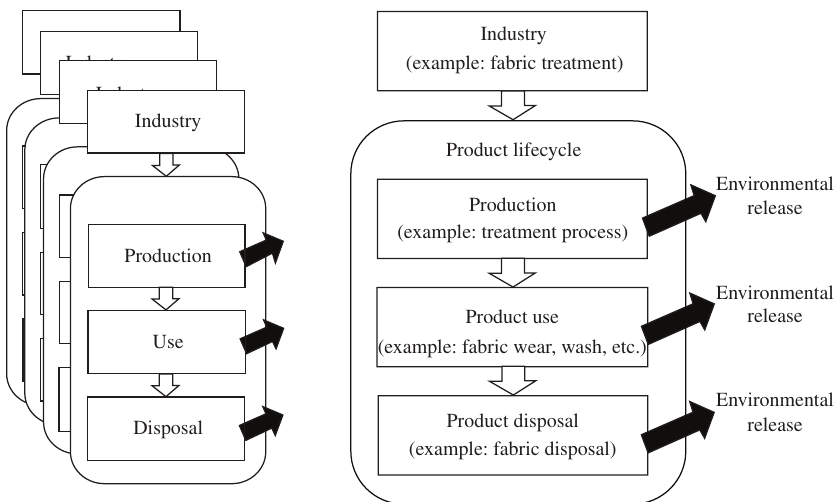
FIGURE 3: Conceptualization of PFOS “Lifecycle” inventory methodology. Each industry necessitates determination of PFOS amount used and percentages emitted during each stage of lifecycle.